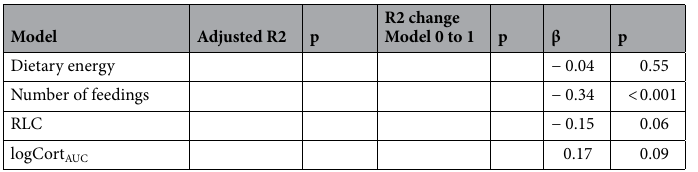
Table 5. Maternal stress (RLC) and total cortisol level (logCort AUC ) predict the main nutrients of breast milk. Significant associations (p < 0.05) between maternal stress and cortisol levels were found for concentrations of milk fat, lactose, and energy in milk samples collected from mothers.